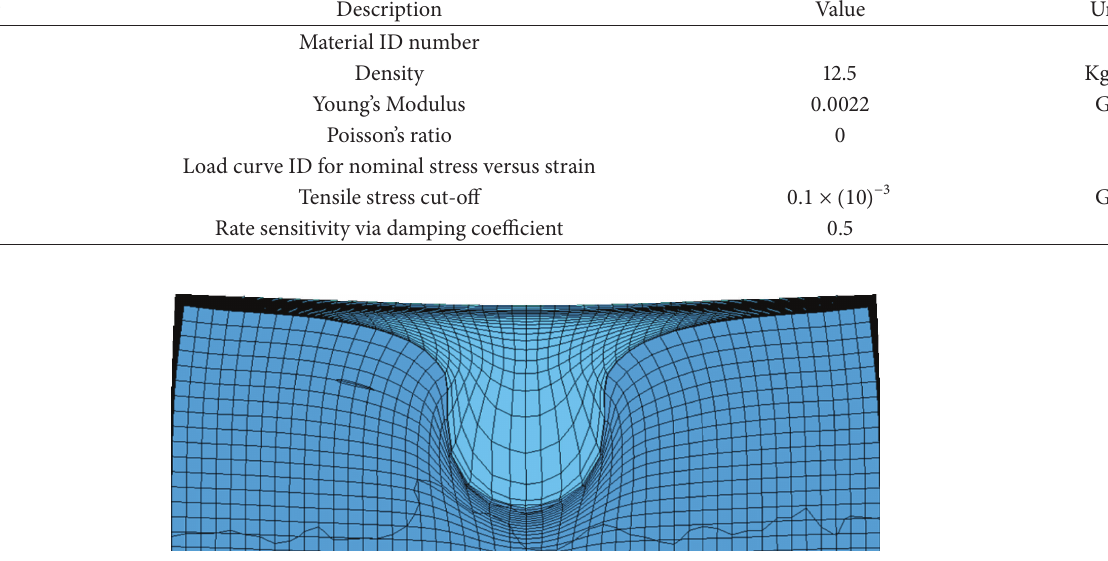
Figure 8: Deformation of EPS foam without introducing failure